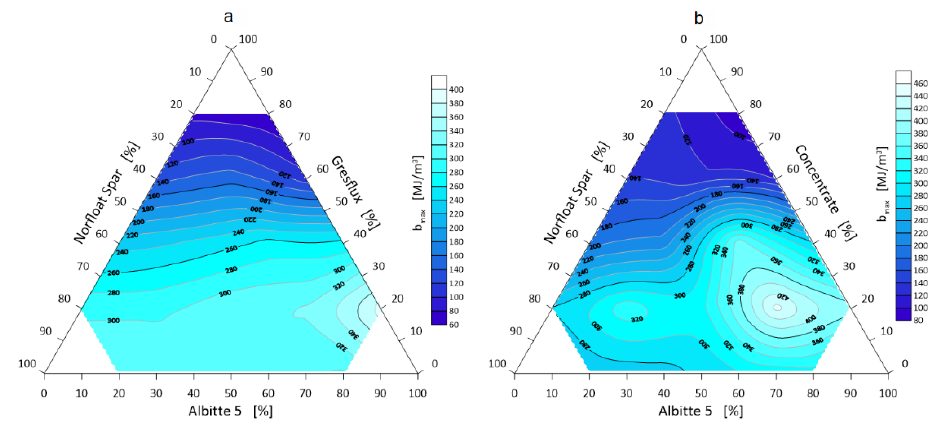
Figure 12. Maximum volumetric energy bmax of the three-component system Greslux ( a ) /Concen- trate ( b )–Albitte 5–Norfloat Spar.